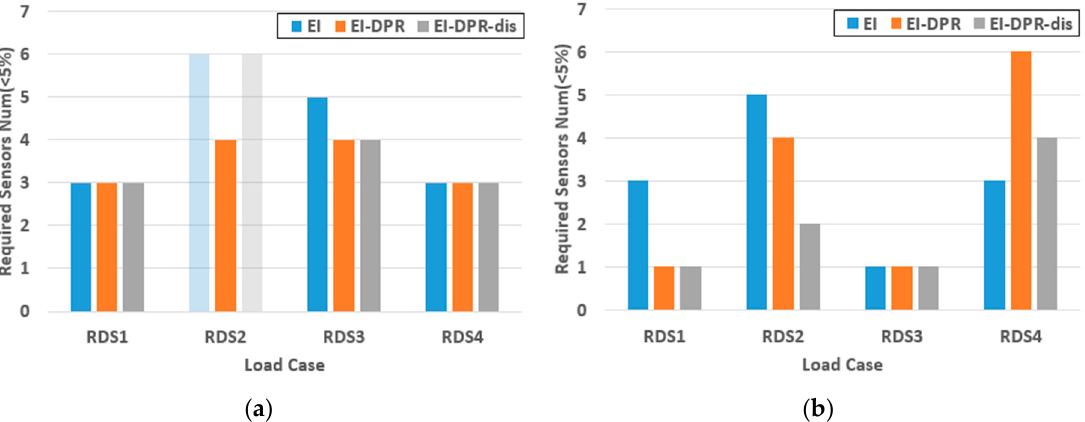
Figure 18. Required number of sensors by each sensor placement method (NMAPE < 5%): ( a ) Case 1: slope only; ( b ) Case 2: strain with one displacement.